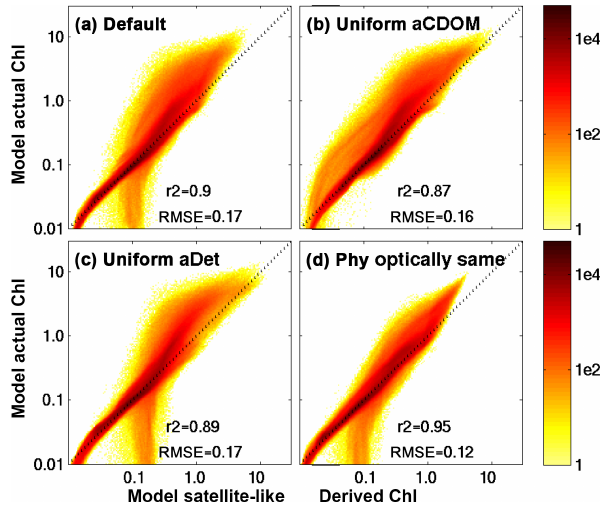
Figure 11. Results from sensitivity experiments. Two-dimensional density histogram of model “actual” and model “derived” Chl a us- ing algorithm coefficients found for (a) default experiment using approach 1 (global, subsampled output, GS), (b) EXP-1 (uniform and constant a CDOM ) approach 1, and (c) EXP-2 (uniform and con- stant a det and b det ) approach 1, (d) EXP-3 (no optical differences between phytoplankton) approach 1. The dashed line indicates the 1-to-1 line. Colour indicates the log of the fraction of all data that occur in phase space (the lightest yellow reflects a single instance in that bin). Statistics noted on the plot are for the log transformed output. The r 2 and RMSE in linear space is provided in Table 3. In these plots, monthly mean output of Chl a and R RS were used to calculate the algorithm, and only monthly mean output is shown (4 million versus 140 million points), thus at a great computational savings. The difference in the algorithm for the default simulation is shown in Fig. 4 (the light blue line is the algorithm with coefficients found using daily values, versus the solid black line where coef- ficients where found using monthly values). Differences between Figs. 11a and 5a are due to this difference in sampling (discussed in Appendix B). Also notice the difference in values on the colour bars between this figure and Fig.